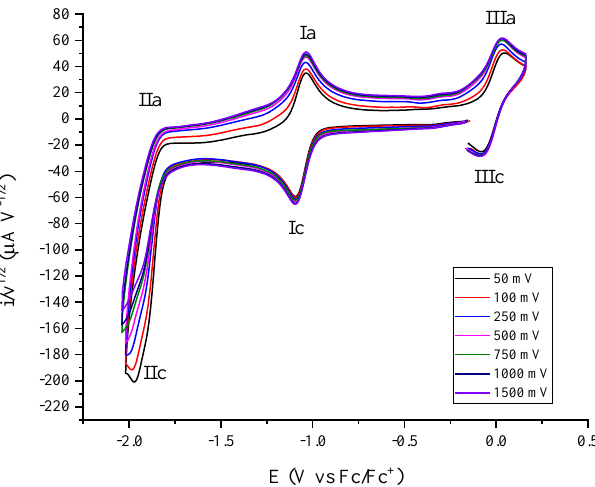
Figure 11. Normalized current cyclic voltammetry of 1 mM [Co II (4-Cl-terpy) 2 ](BF 4 ) 2 solution in